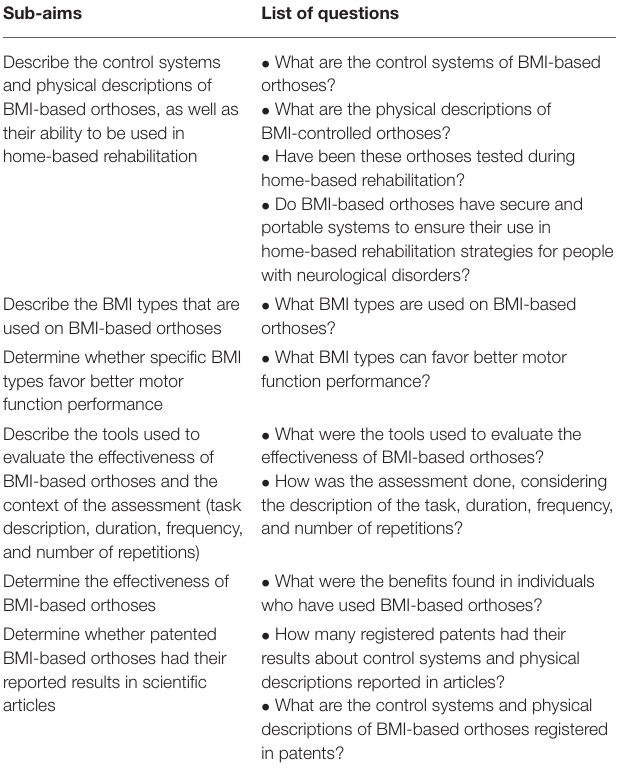
TABLE 1 | Research